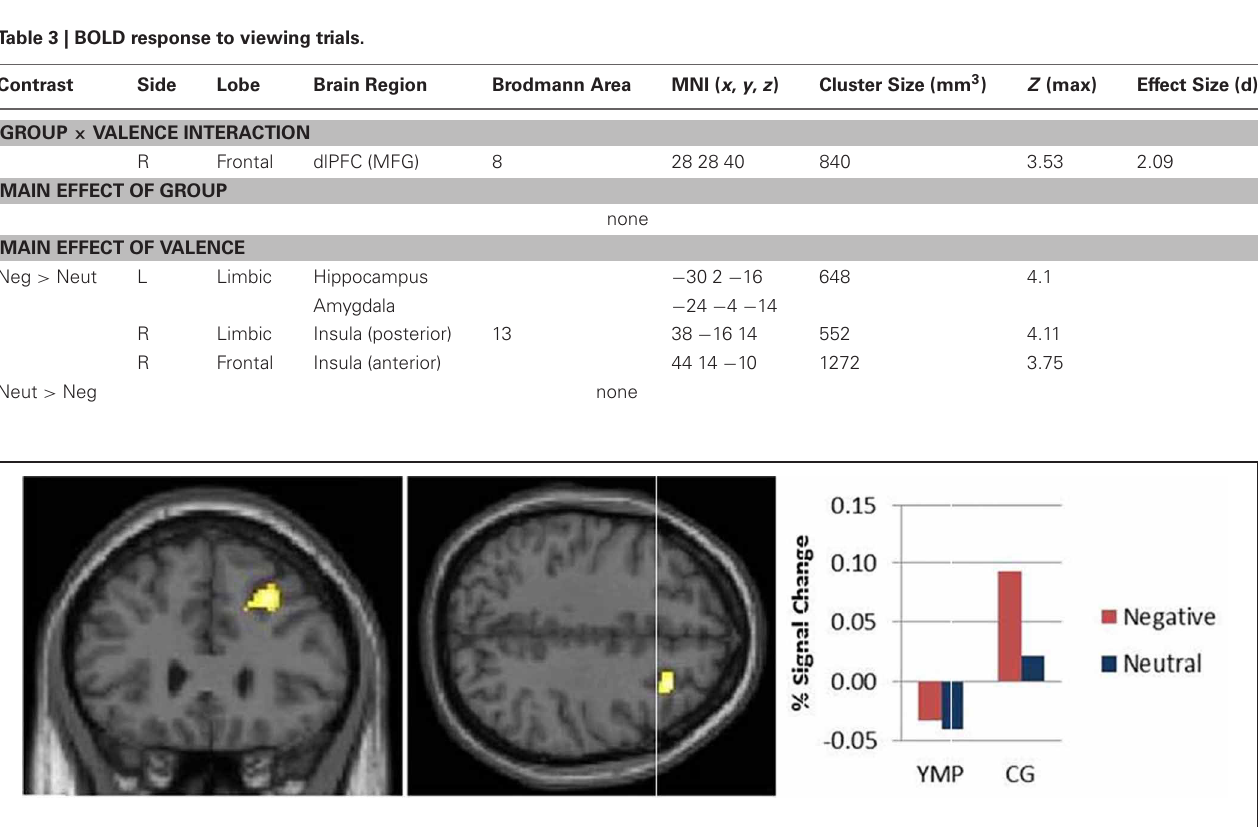
FIGURE 2 | fMRI contrast of the Group × Valence interaction on BOLD response during viewing emotional images. Among the control group, activation was greater during negative versus neutral images and as compared to YMP in right middle frontal gyrus (MFG) ( x = 28, y = 28, z = 40).